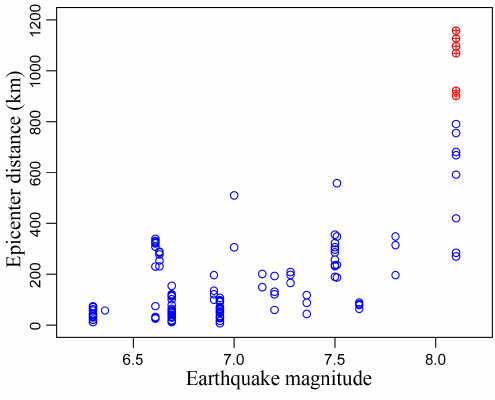
Figure 6. Distribution of magnitudes and epicenter distances of observed ground motions used in this